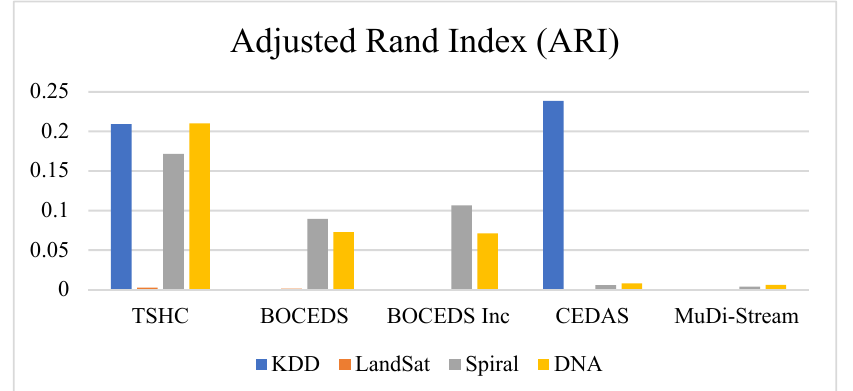
17 of 22 Figure 5. Rand Index Comparison Using KDDCup’99, Landsat, Spiral, and DNA Datasets. 4.1.3. Adjusted Rand Index (ARI) The adjusted rand index (ARI) is a development of the rand index (RI). It is recom- mended as the index of choice when comparing two partitions in a clustering analysis with a variable number of clusters. The adjusted rand index (ARI) is defined as the fol- lowing: 𝐴𝑅𝐼 = (cid:4672)𝑛 2(cid:4673)(|𝑇𝑃| + |𝑇𝑁|) − [(|𝑇𝑃| + |𝐹𝑁|)(|𝑇𝑃| + |𝐹𝑃|) + (|𝐹𝑝| + |𝑇𝑁|)(|𝐹𝑁| + |𝑇𝑁|)] (cid:4672)𝑛 2(cid:4673) (cid:2870) − [(|𝑇𝑃| + |𝐹𝑁|)(|𝑇𝑃| + |𝐹𝑃|) + (|𝐹𝑃| + |𝑇𝑁|)(|𝐹𝑁| + |𝑇𝑁|)]